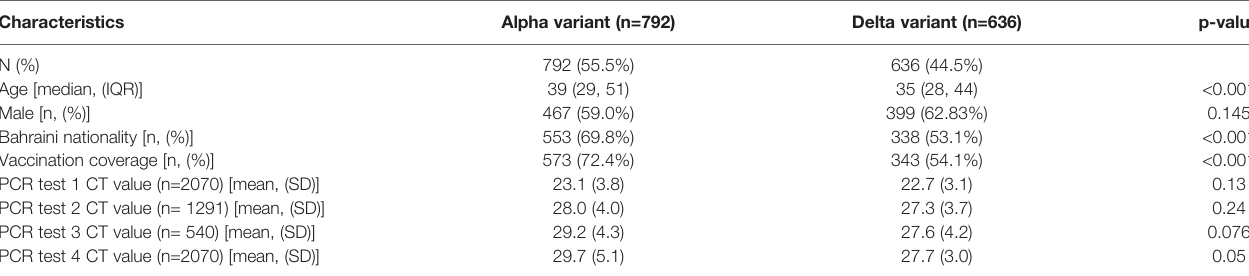
TABLE 1 | Characteristics of the study subjects.